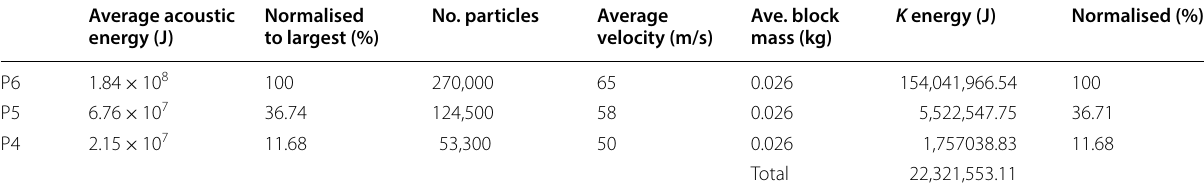
Table 2 Relative kinetic energy of eruption bursts and consequent number of blocks modelled Average acoustic Normalised No. particles Average Ave. block K energy (J) Normalised (%) energy (J) to largest (%) velocity (m/s) mass (kg)